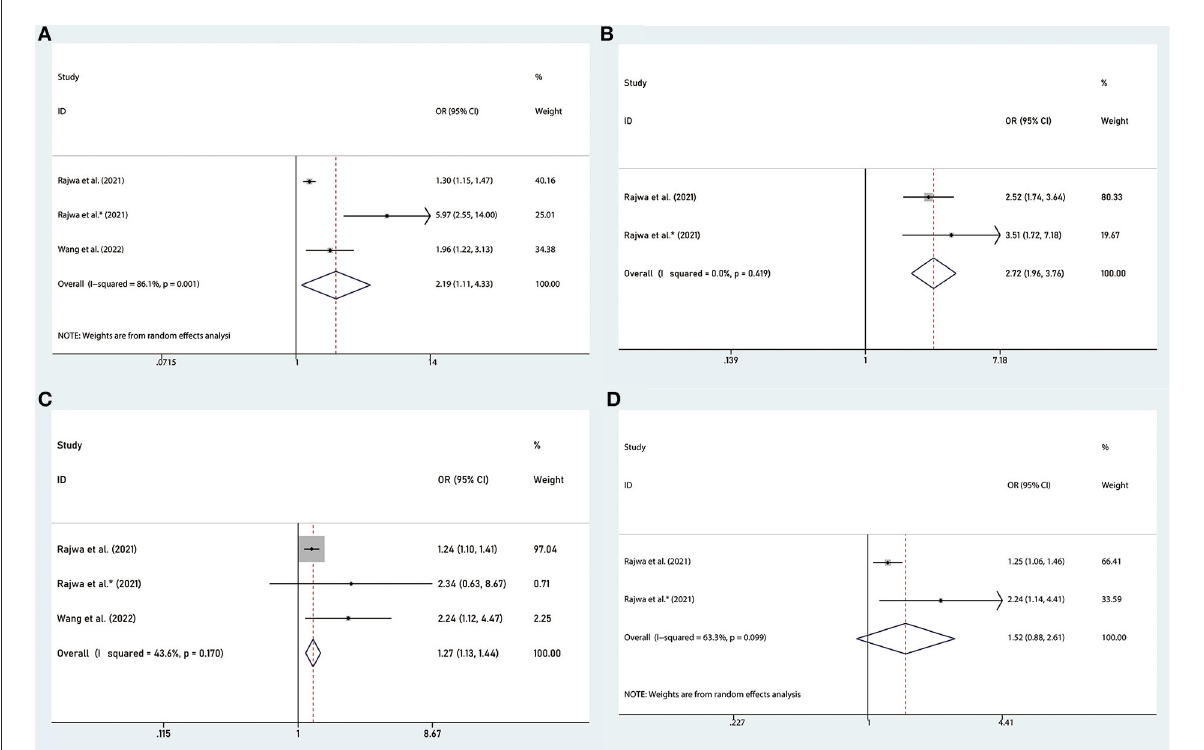
FIGURE5 Forest plots of the association between SII and adverse clinicopathology in nmPCa: (A) pathological tumor stage ≥ 3, (B) pathological lymph node stage ≥ 1, (C) Gleason score ≥ 7, and (D) positive surgical margins. SII, systemic immune-inflammation index; nmPCa, non-metastatic prostate